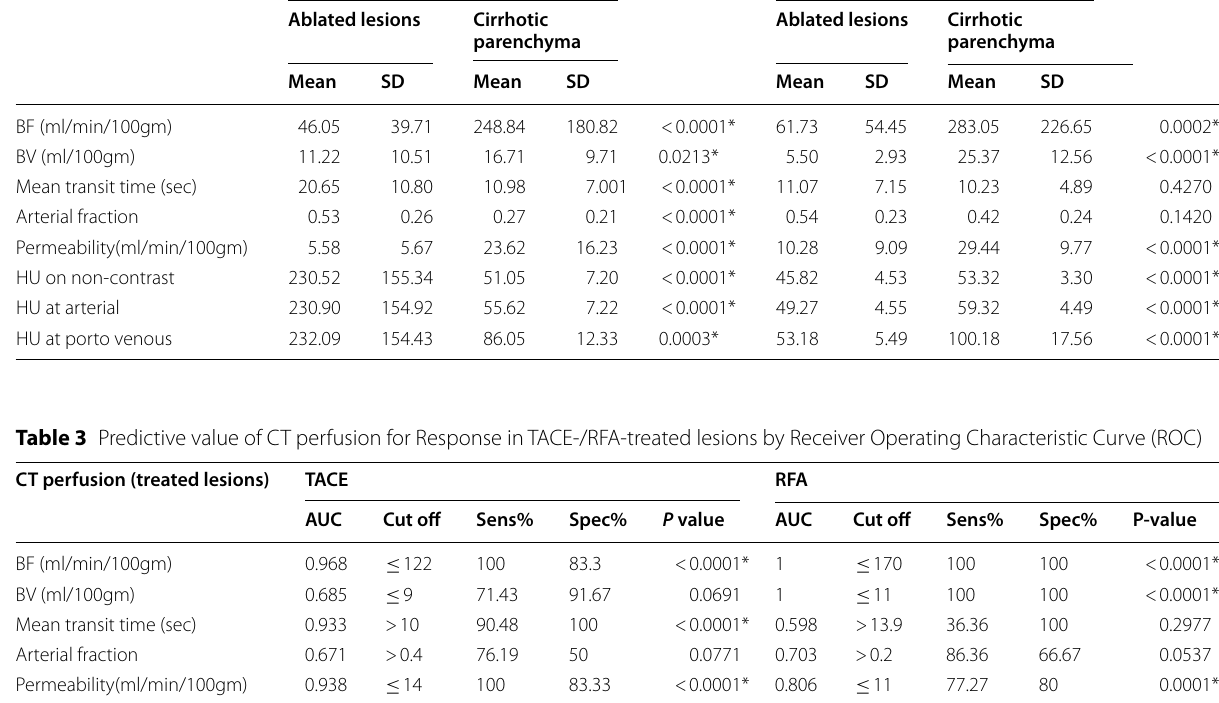
Table 2 Association between CTP parameters and ablated/cirrhotic lesions CT perfusion